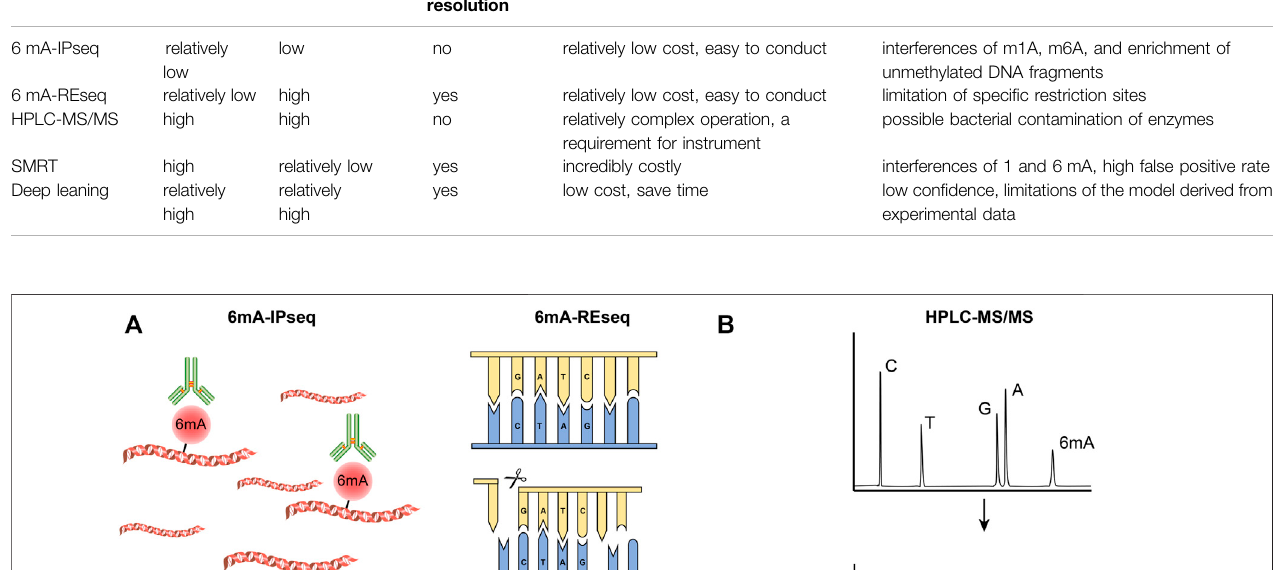
TABLE 1 | Advantages and disadvantages of 6 mA detection methods. Detection methods